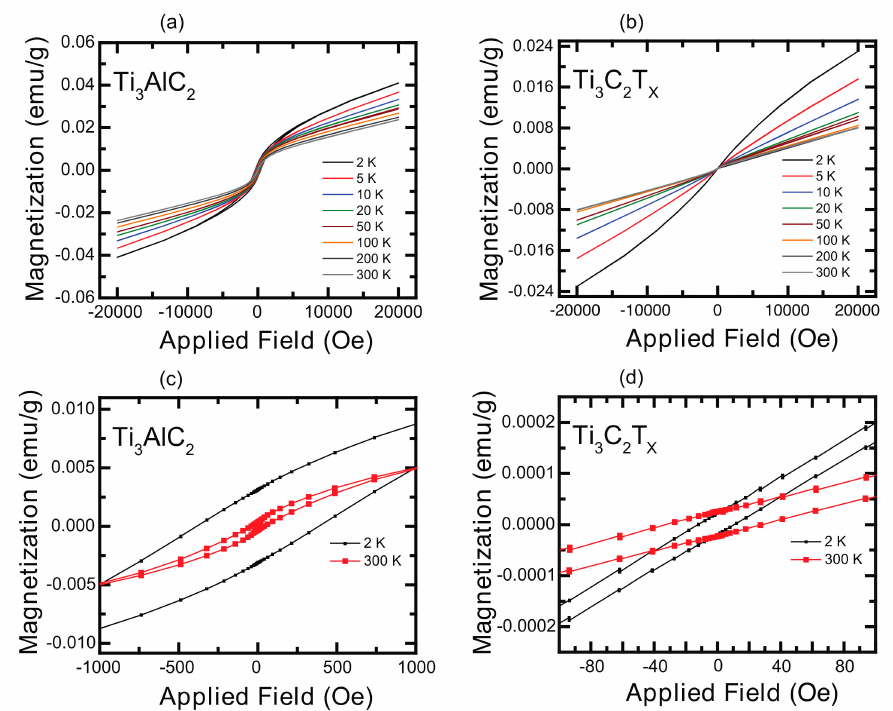
Figure 3. Magnetization versus applied magnetic field for ( a , c ) Ti 3 AlC 2 and ( b , d ) LiF etched Ti 3 C 2 T X samples.